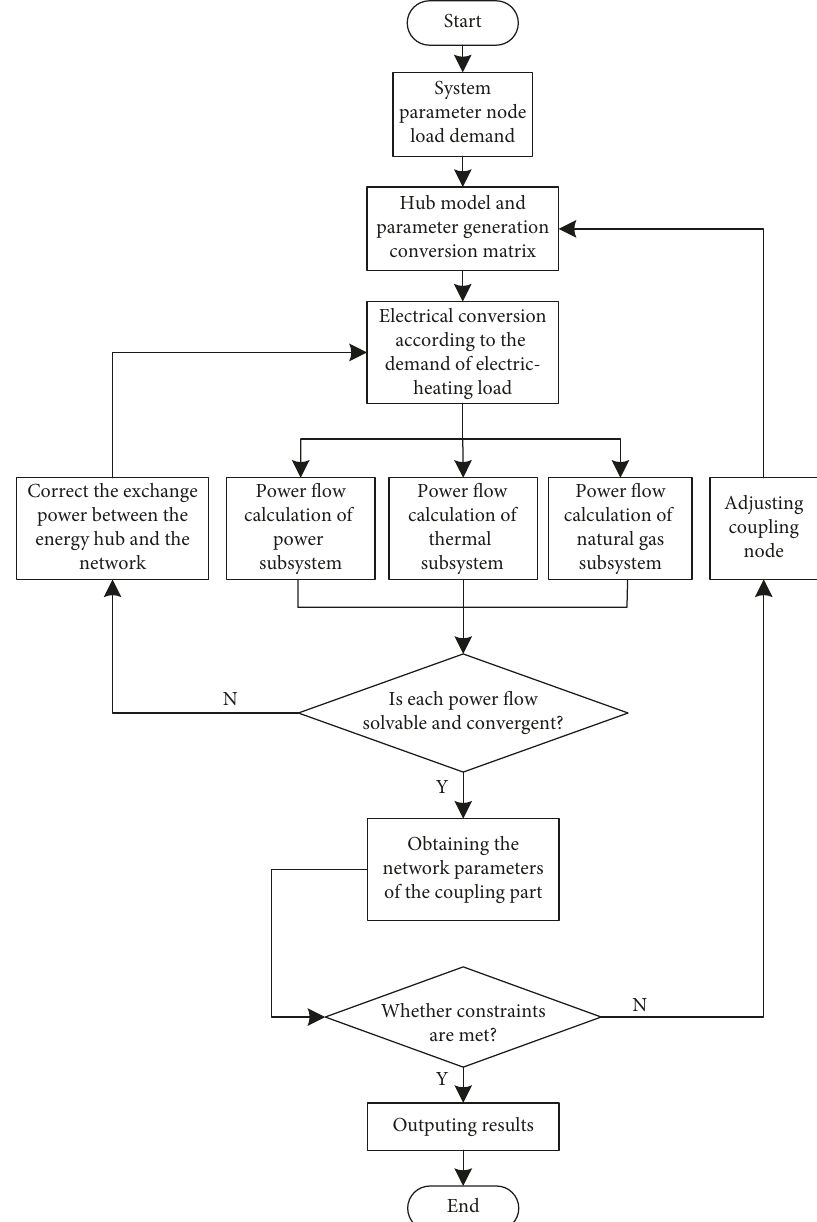
Figure 1: Flow chart of power flow decomposition